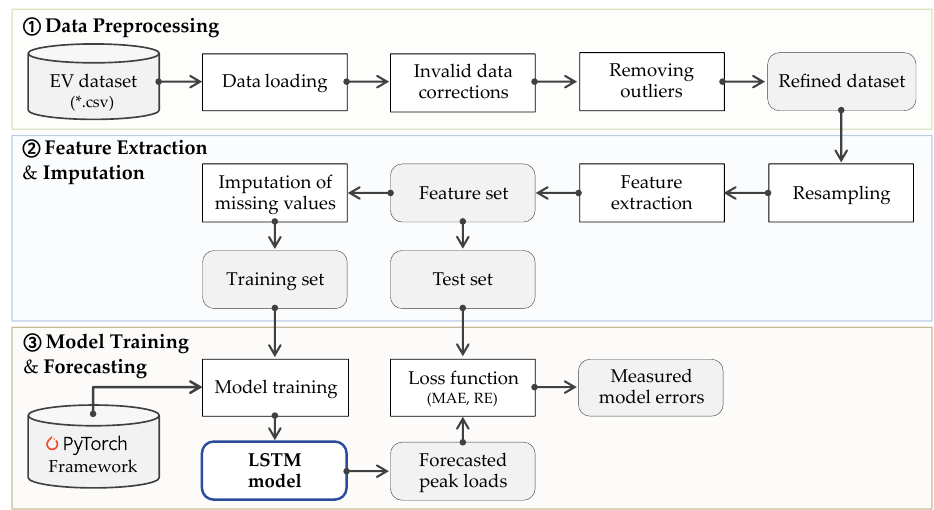
Figure 5. The overall procedure for developing the forecasting